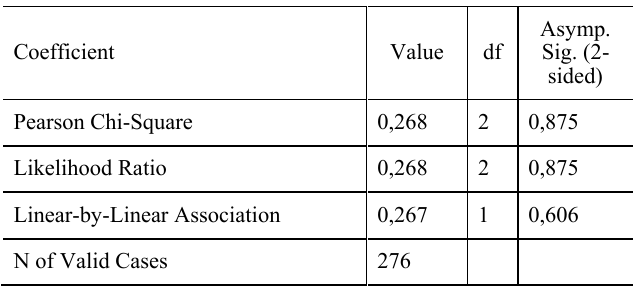
Table 12b: Chi-square